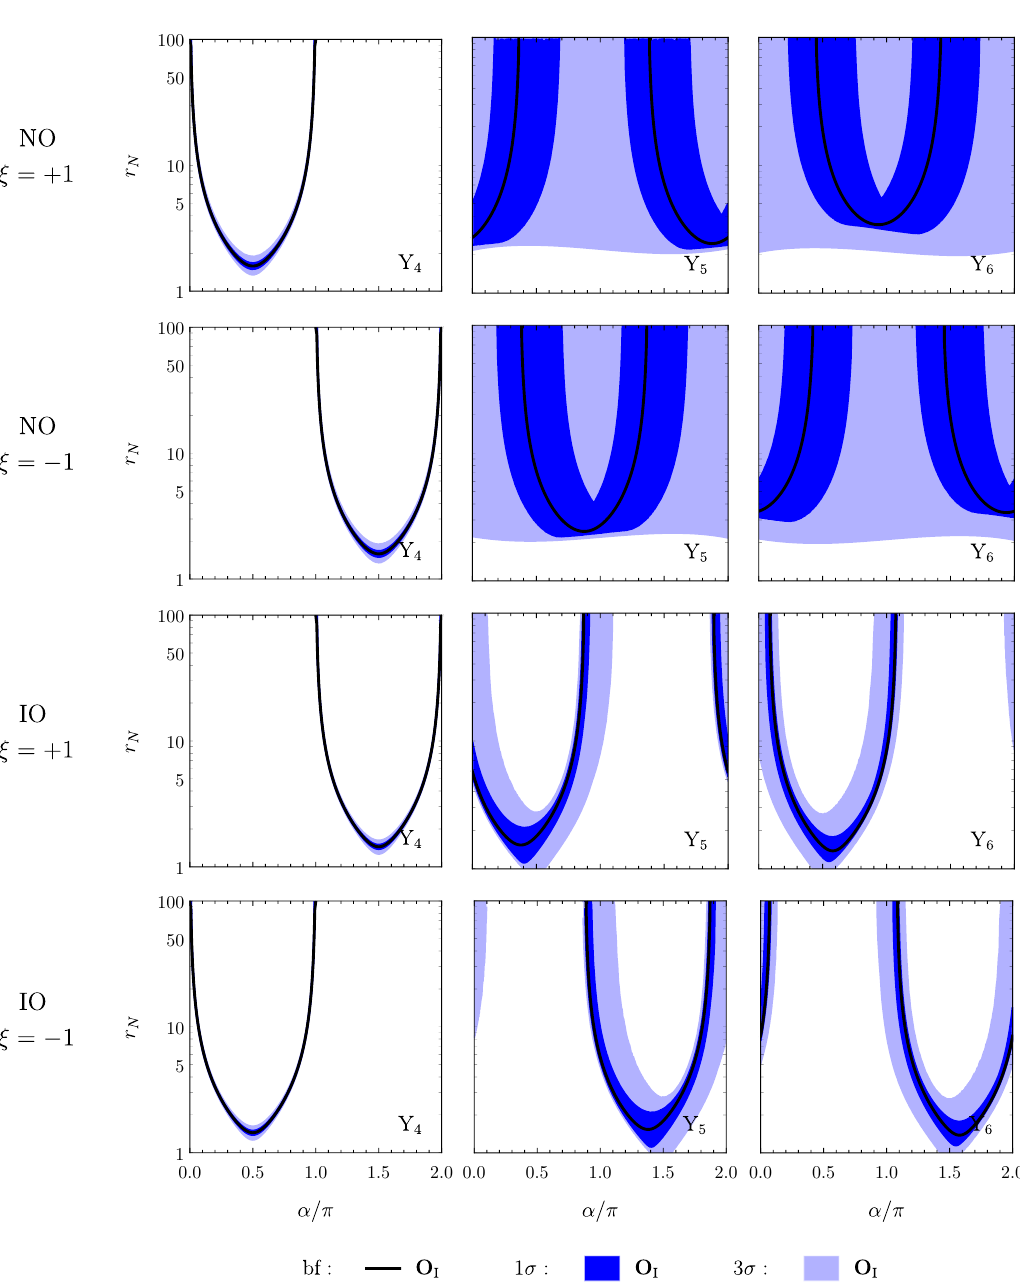
Figure 3 . Allowed regions in the ( (cid:11) , r N ) plane for all (R 2 ,Y 4 (cid:0) 6 ) combinations, both for NO (upper plots) and IO (lower plots), (cid:24) = (cid:6) 1, and O of the type O I . The light (dark) coloured regions were obtained varying (cid:18) ij , (cid:1) m 2 and (cid:14) within the 3 (cid:27) (1 (cid:27) ) experimental ranges given in table 1. The ij black solid lines are the ( (cid:11) , r N ) curves computed with the best-(cid:12)t values for neutrino data. Here, we only present the case where O is of the type O I , since it is the only one that depends on r N